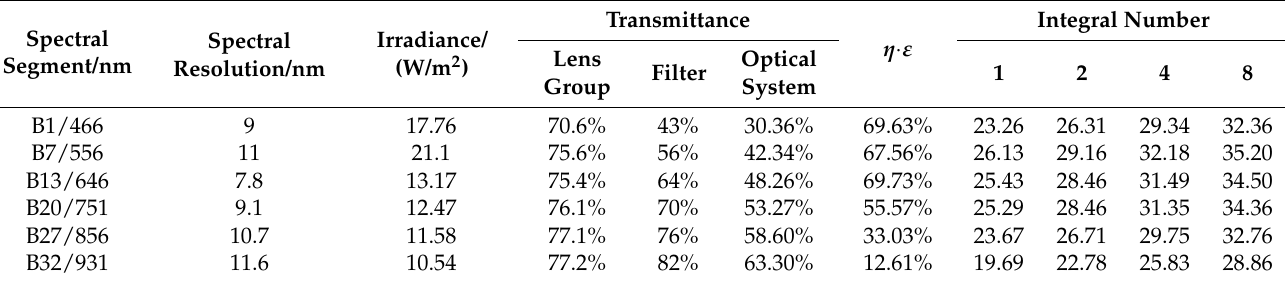
Table 2. Signal-noise ratio analysis results (unit: